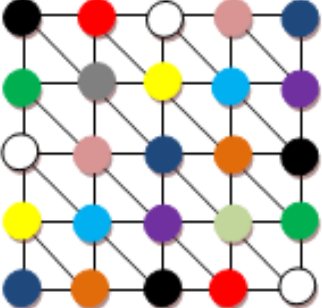
Figure 5. Clique for the L(2,1,1) coloring.